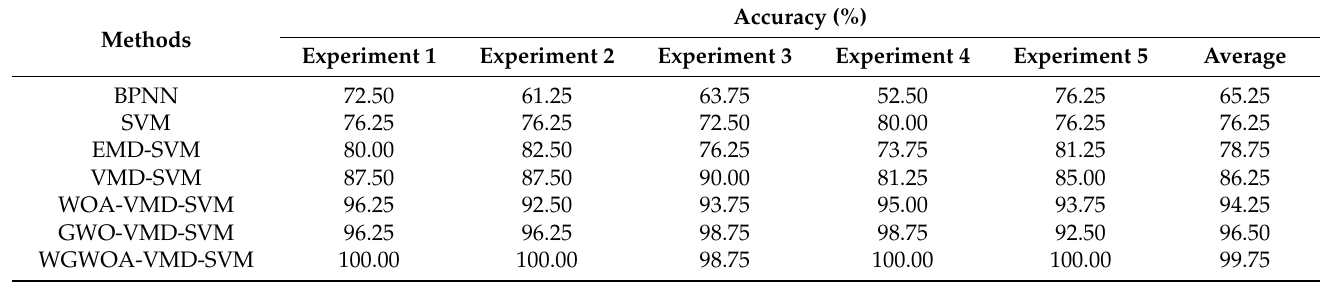
Table 8. Diagnostic accuracy of different method tests.